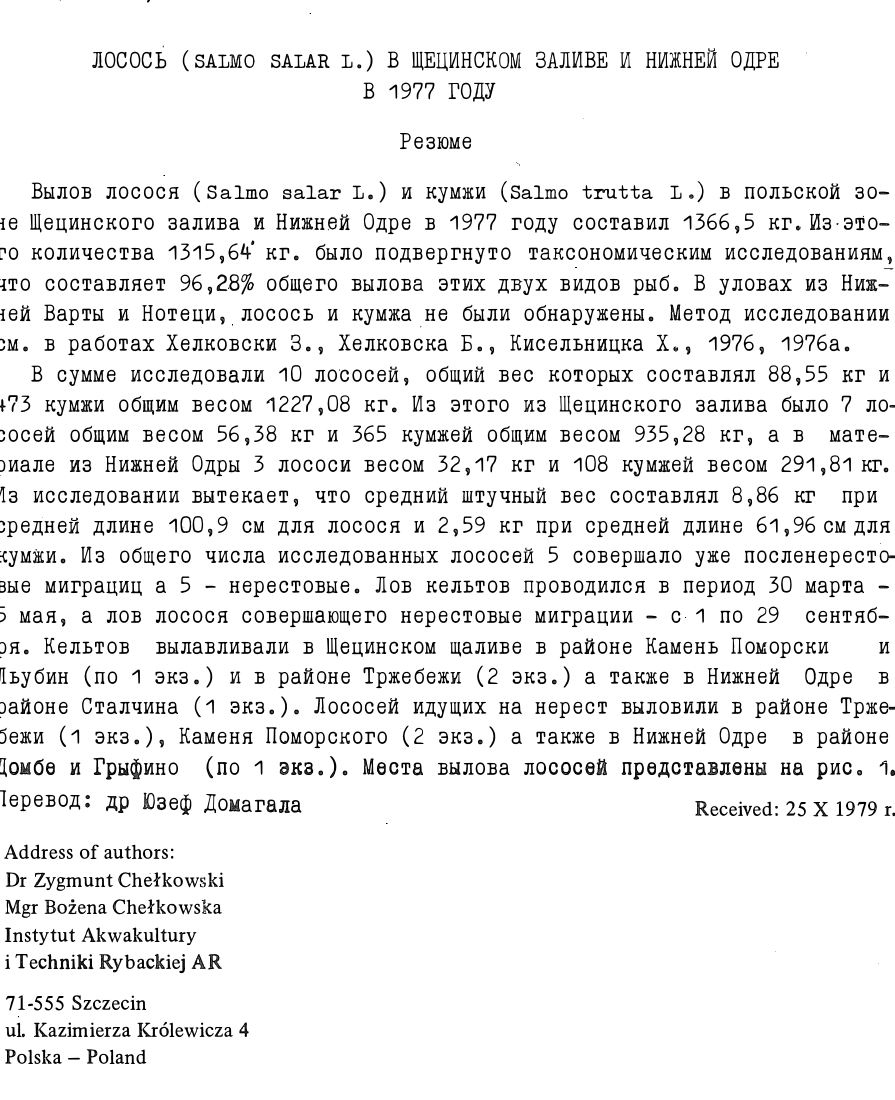
8.XB.llKOBCKlll, E. XBJIKOBCKa